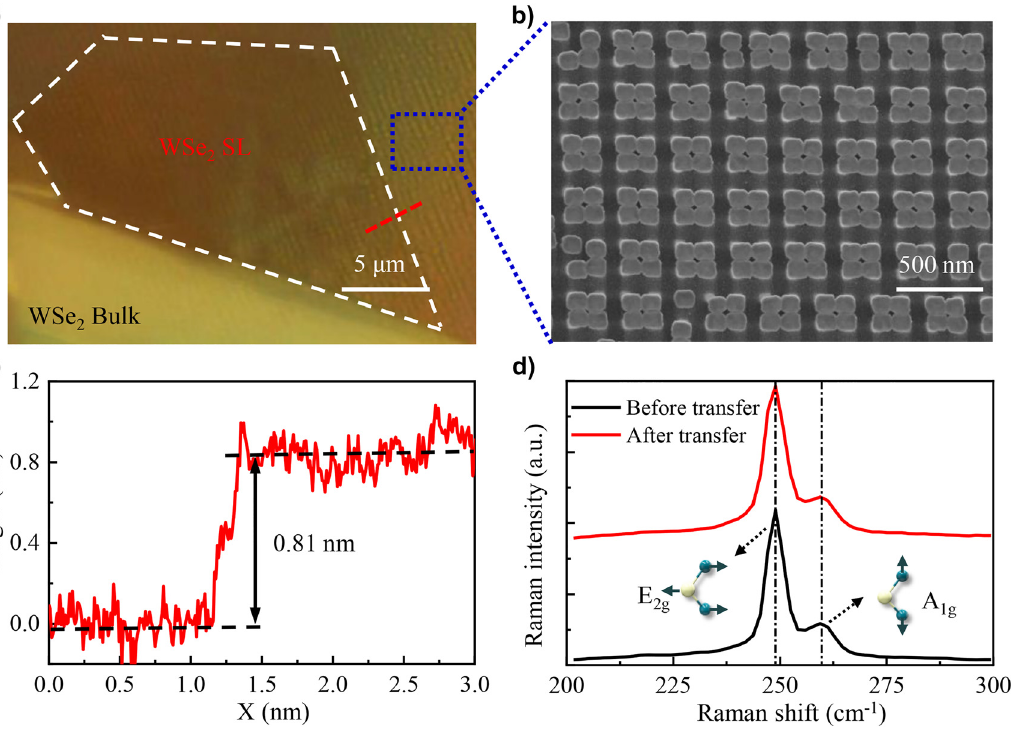
Figure 2: Monolayer WSe 2 transferred onto plasmonic nano fi nger arrays. (a) The microscope image of the as-prepared WSe 2 -nano fi nger sample. (b) Top-view SEM image of 1 nm ta-C coated Au nano fi ngers after collapse at the blue rectangleposition in (a). (c) Height pro fi le scanned with an AFM along red dash-line of sample in (a). (d) Raman spectra of monolayer WSe 2 before and after transfer from silicon on insulator (SOI) to nano fi